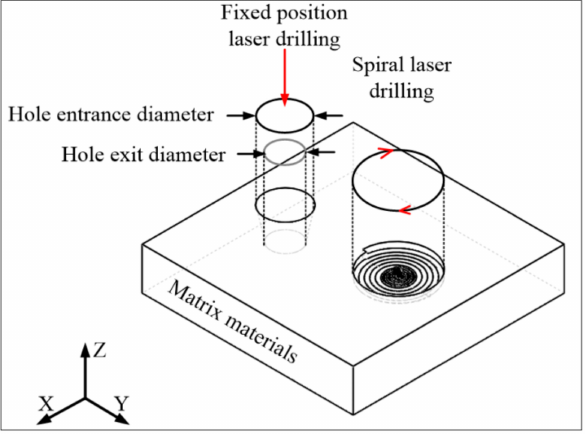
Figure 2. Strategies used for water jet-guided laser